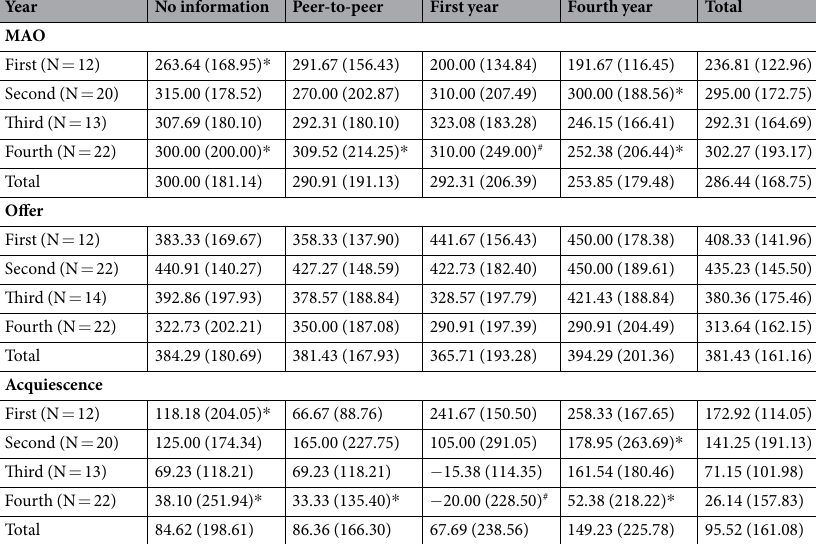
Table 1. Means (standard deviation) of MAO, offer, and acquiescence in the four games. Some participants responded non-linearly when indicating which offers they would accept. We therefore could not calculate these participants’ MAO and acquiescence, and so they were excluded from the relevant analyses. * Indicates that one participant was excluded, and # indicates that two participants were excluded due to a non-linear response.